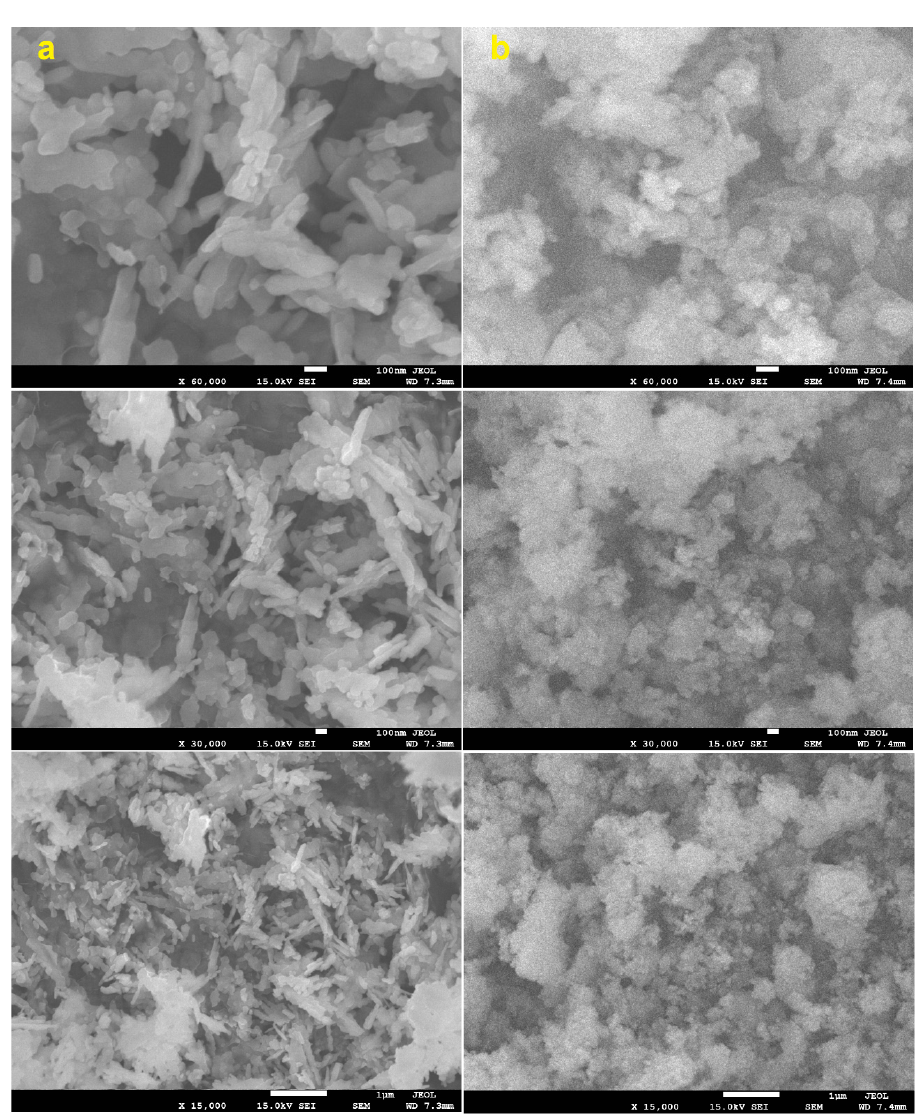
Figure 2. Scanning electron microscope (SEM) images for ( a ) T CuO NPs and ( b ) G CuO NPs.